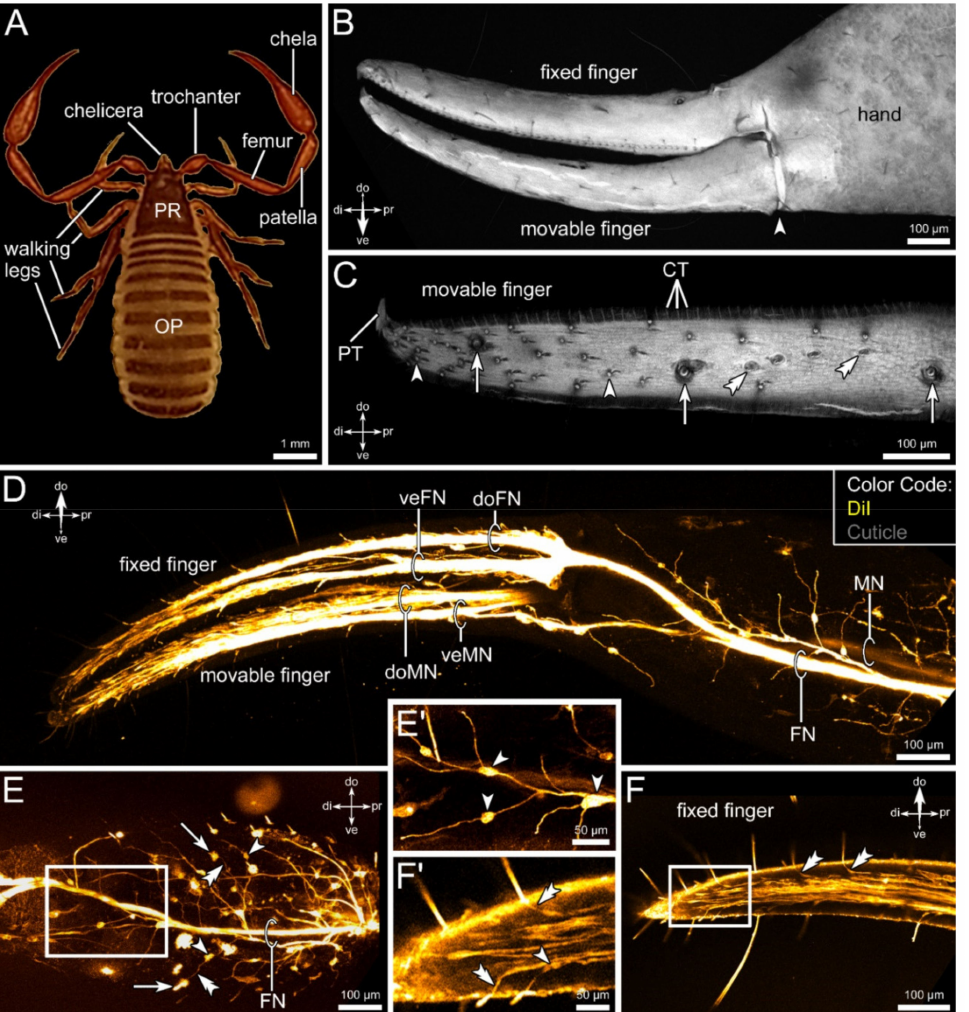
Figure 1. General morphology, the sensory equipment, and neuronal innervation of the pedipalps of Chelifer cancroides . ( A ) Dorsal view of the animal, showing the four pairs of walking legs, the chelicera, and the large pedipalps, consisting of the trochanter, femur, patella, and the chela (tibia + tarsus). All appendages are associated with the prosoma (PR). The opisthosoma (OP) does not possess any appendages. ( B ) Overview of the chelal surface stained with Congo red (gray). The chela possesses two fingers, a dorsal fixed finger, and a ventral movable finger (joint indicated by arrowhead). ( C ) Detail of the movable finger, showing the sensory equipment with different types of sensilla, e.g., trichobothria (arrows), shorter hair-sensilla (double arrowheads), and club-shaped sensilla (arrowheads). The chelal teeth (CT) and poison tooth (PT) are indicated. ( D ) Overview of the innervation of the chela based on lipophilic dye injection (DiI, yellow). Within the chelal hand, two main fibers can be distinguished, each innervating one of the fingers (FN: fixed finger nerve; MN: movable finger nerve). Shortly after entering the fingers, these nerves split into two branches (veFN, doFN: ventral and dorsal nerve of fixed finger; veMN, doMN: ventral and dorsal nerve of movable finger). ( E , E’ ) Details of the innervation of the chelal hand. From the main nerve branches (FN shown), various branches split of and send fine branches (double arrowheads in ( E )) toward sensory structures at the cuticle surface (arrows in ( E )). Along these fine fibers, swellings of cell bodies can be observed (arrowheads in ( E , E’ )). ( F , F’ ) Details of the innervation of the fixed finger. From the dorsal and ventral nerve branches within the fingers, numerous fibers branch off and innervate sensory structures (double arrowheads in ( F , F’ )). Again, swellings consisting of cell bodies are present (arrowhead in ( F’ )). Other abbreviations: di: distal; do: dorsal; pr: proximal; ve: